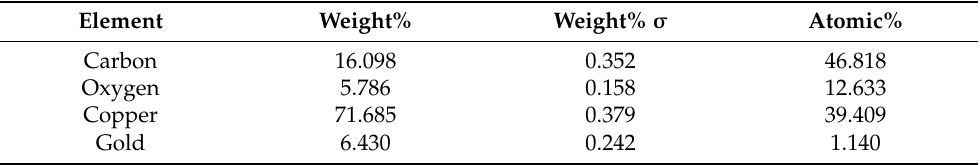
Table 5. Summary of the results of elemental mapping.